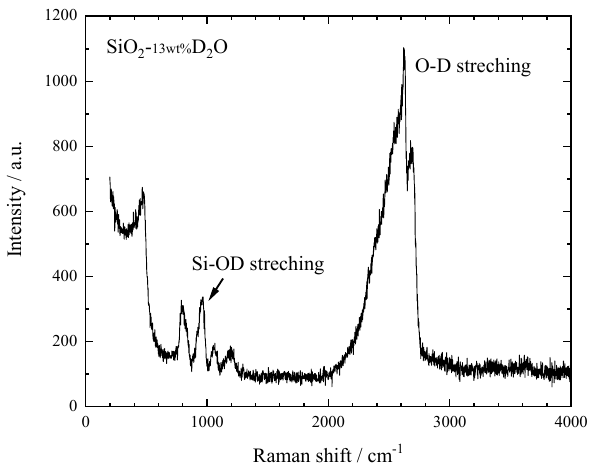
Figure 1. Raman spectrum of the hydrous SiO 2 glass at ambient conditions. Spectrum is unpolarized.